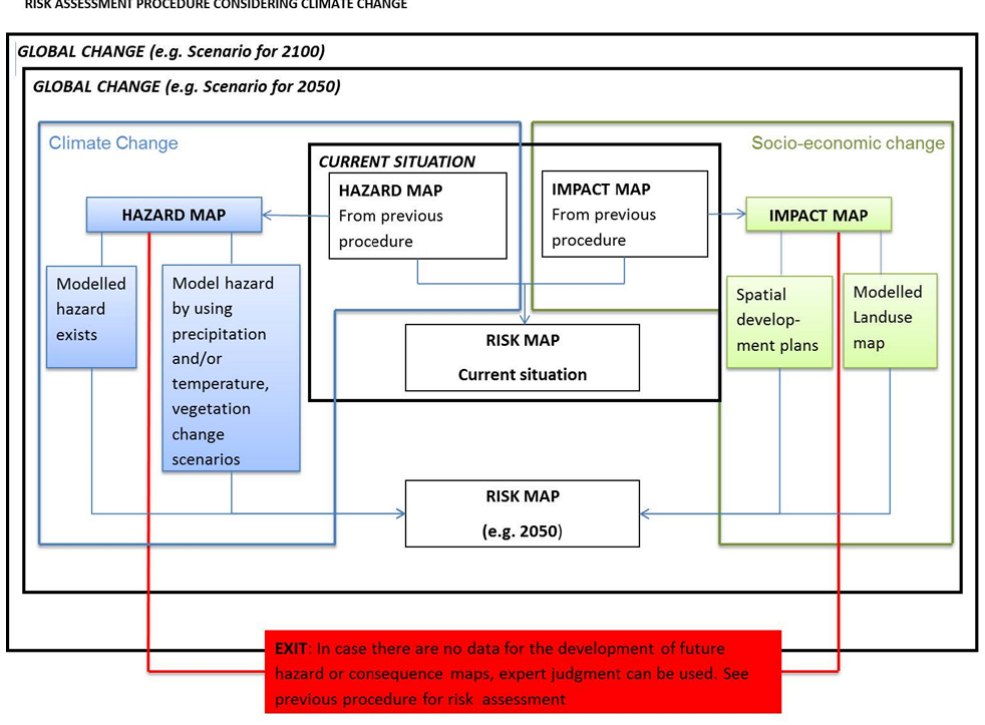
Figure 14. Consideration of global change for future risk assessment [46].